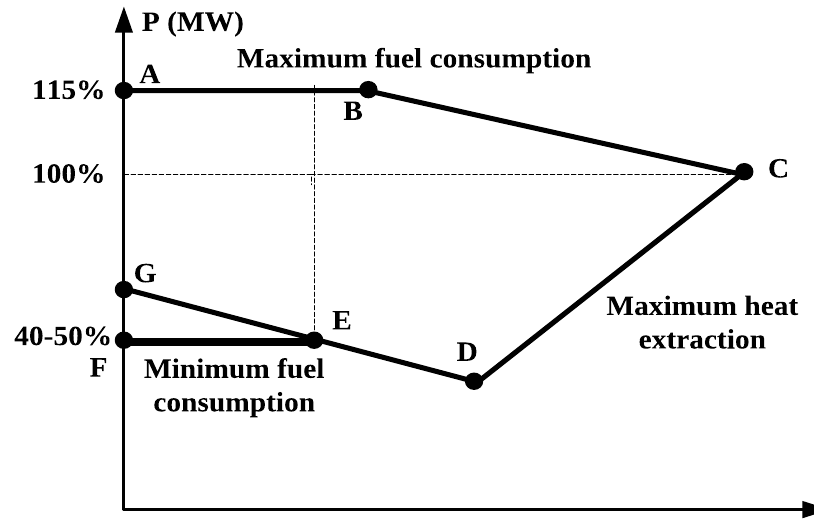
Figure 2. Non-convex feasible operation region (FOR) of CHP